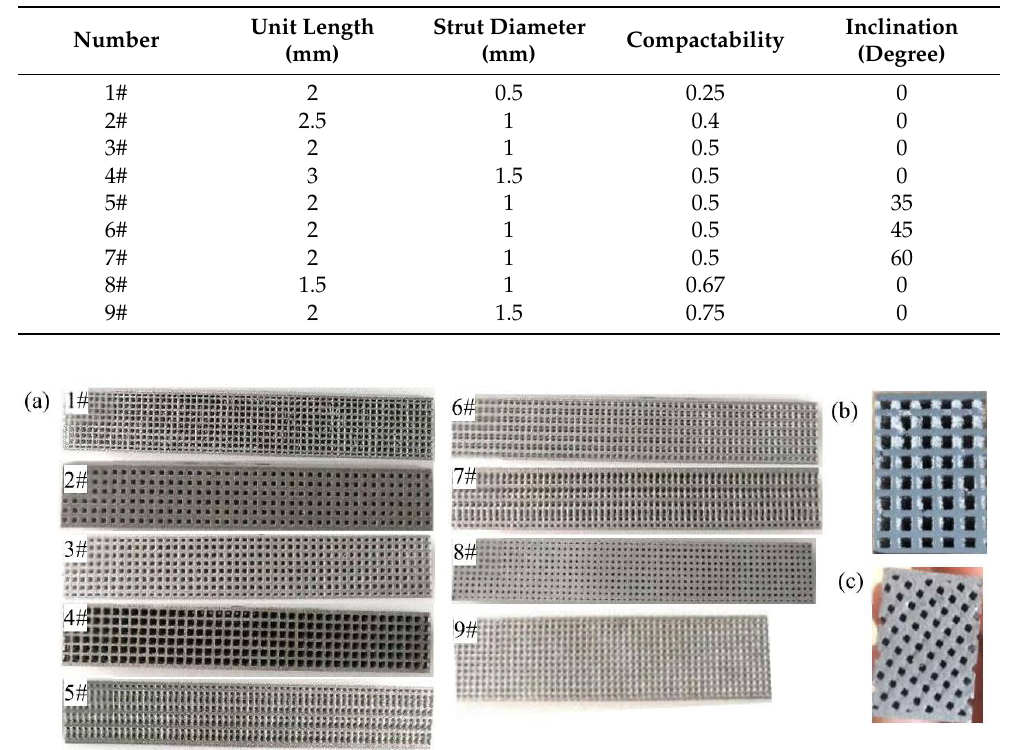
Figure 1. Material and structure of specimens: ( a ) AlMgSc alloy powder after atomization spray forming; ( b ) schematic diagram of specimen model. Table 1. Samples with different geometric parameters.